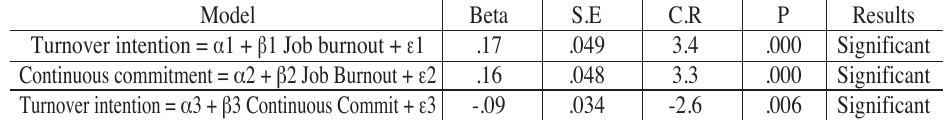
Continuous Commitment b/w Job Burnout and Turnover Intention